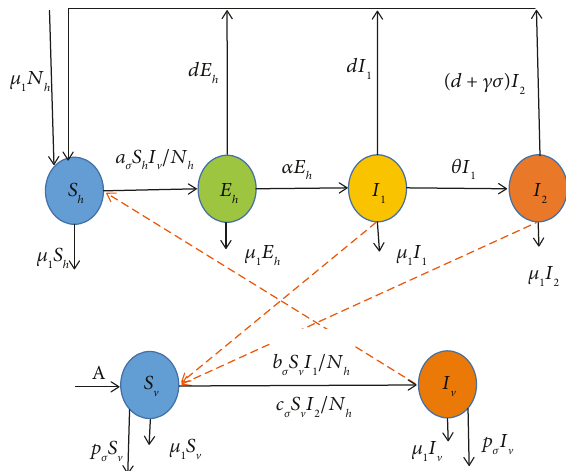
Figure 1: A schematic of model (4) showing transitions to di ff erent categories for trees and psyllids. Black arrows show the transitions between compartments. Orange dashed arrows show the necessary interactions between trees and psyllids to obtain